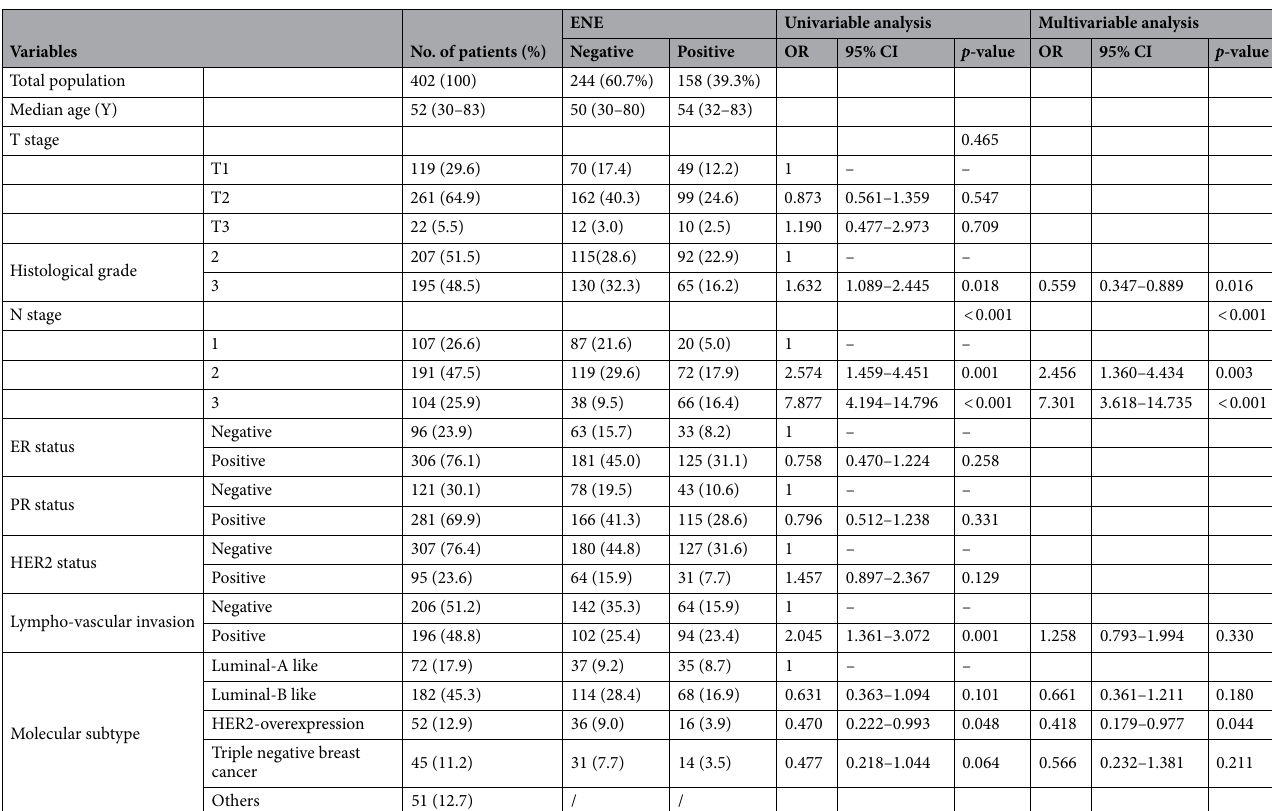
Table 2. Correlations between ENE in ALN and clinicopathological parameters. ER estrogen receptor; PR progesterone receptor; HER2 human epidermal growth factor receptor 2; ENE extranodal